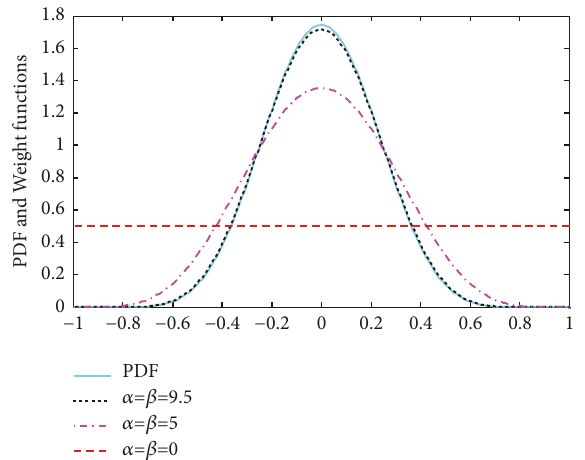
Figure 1: PDF of a random variable and the weight function with different polynomial parameters.